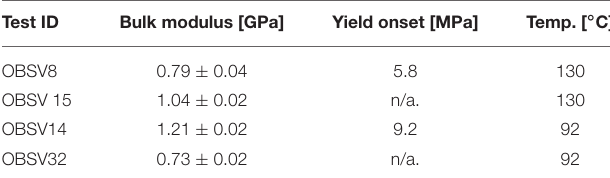
TABLE 3 | Lengths and diameters of the cores after test. TABLE 4 | Mechanical parameters obtained during